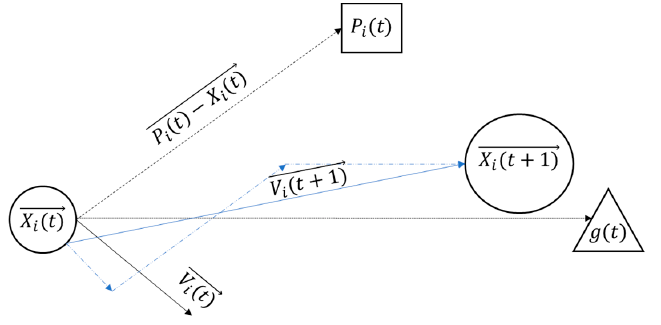
Figure 3. Movement of each particle toward its best position in particle swarm optimization.